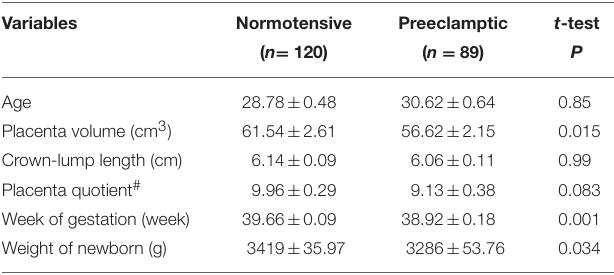
TABLE 1 | Clinical characteristics of normotensive and preeclamptic